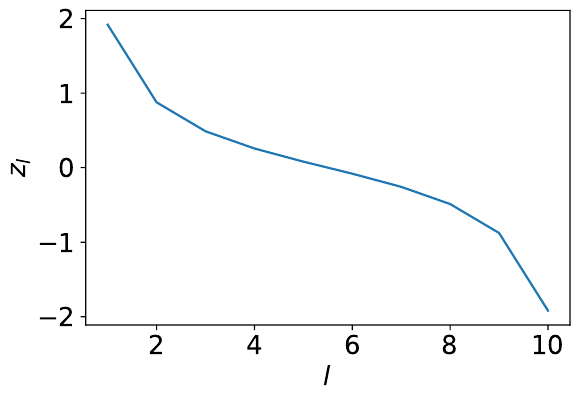
Figure 1: The coefficient z in the measurement operator, see Eq. (9), for M = l